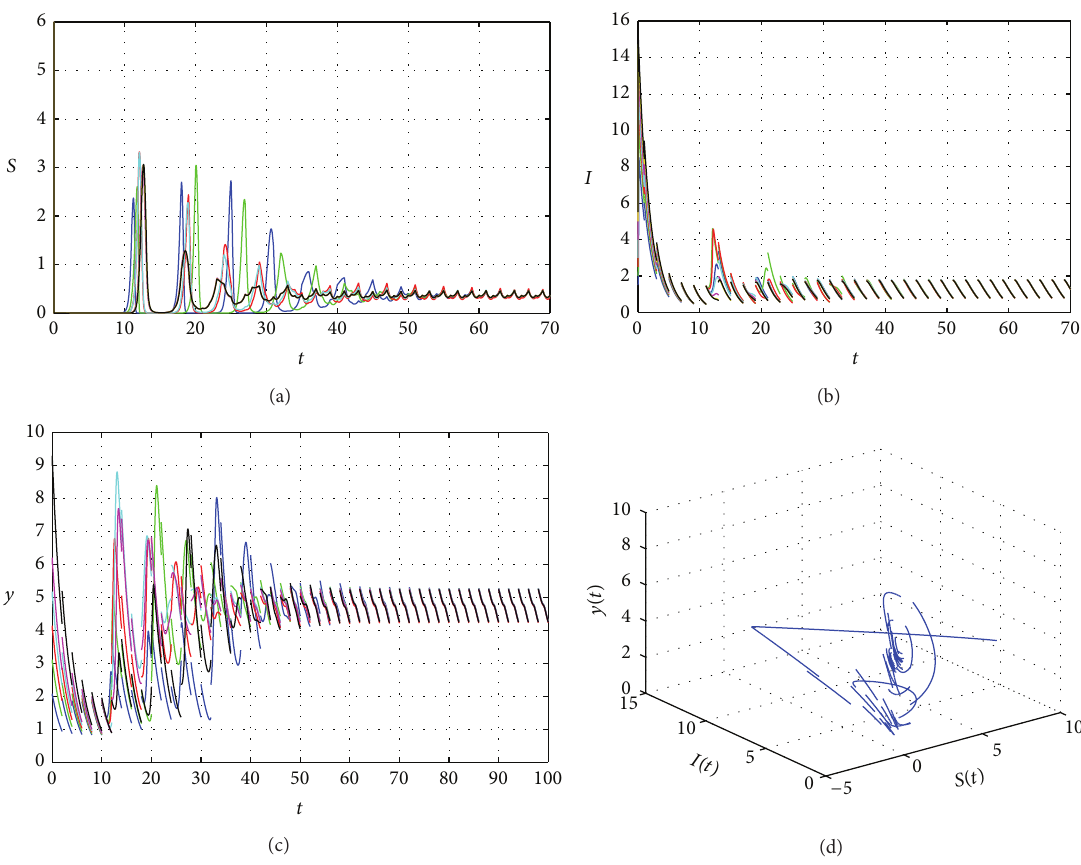
Figure 2: Time sires of 𝑆(𝑡) (a), 𝐼(𝑡) (b), 𝑦(𝑡) (c), and phase portrait (d) in model (1) with the initial values 𝑆(0 + ) = 0.1+0.5𝑘 , 𝐼(0 + ) = 2+0.4𝑘 , and 𝑦(0 + ) = 3 + 0.4𝑘 , 𝑘 = 1, 2, 3, 4,